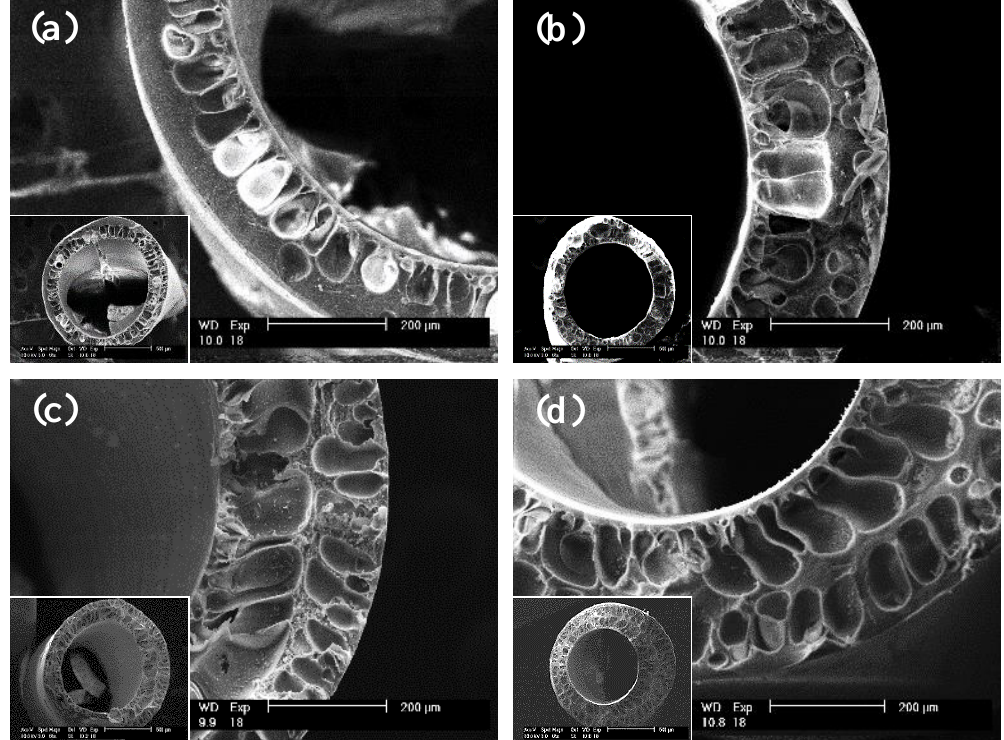
Figure 4: SEM Images of ( a ) the control, ( b ) Form I, ( c ) 50/50, and ( d ) Form II to show pore structure and Figure 4. SEM Images of ( a ) the control, ( b ) Form I, ( c ) 50 / 50, and ( d ) Form II to show pore structure and membrane size at a 200-micron membrane size at a 200-micron scale.